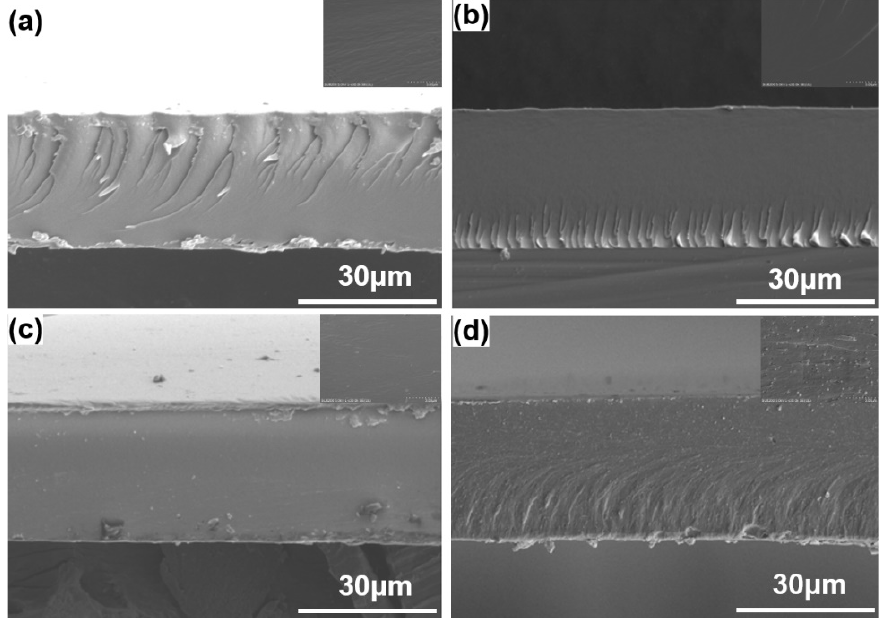
Figure 8. SEM images for section structures of ( a ) D230-PyAL, ( b ) D230-PyAL-Ni, ( c ) D230-PyAL-Cu, and ( d ) D230-PyAL-Sm coatings.